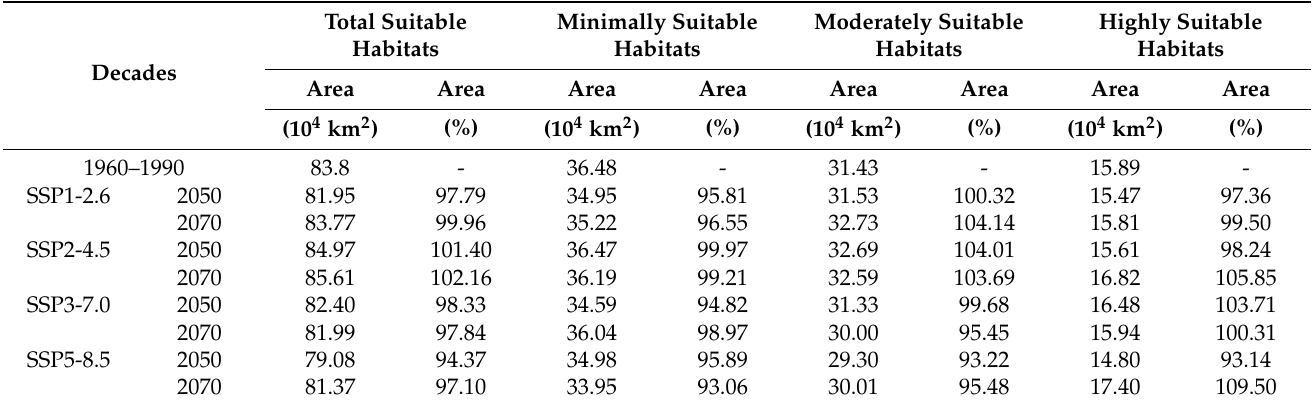
Figure 2. The distribution of V. uliginosum in China. Table 2. Predicted region and percentage of contemporary predicted region.